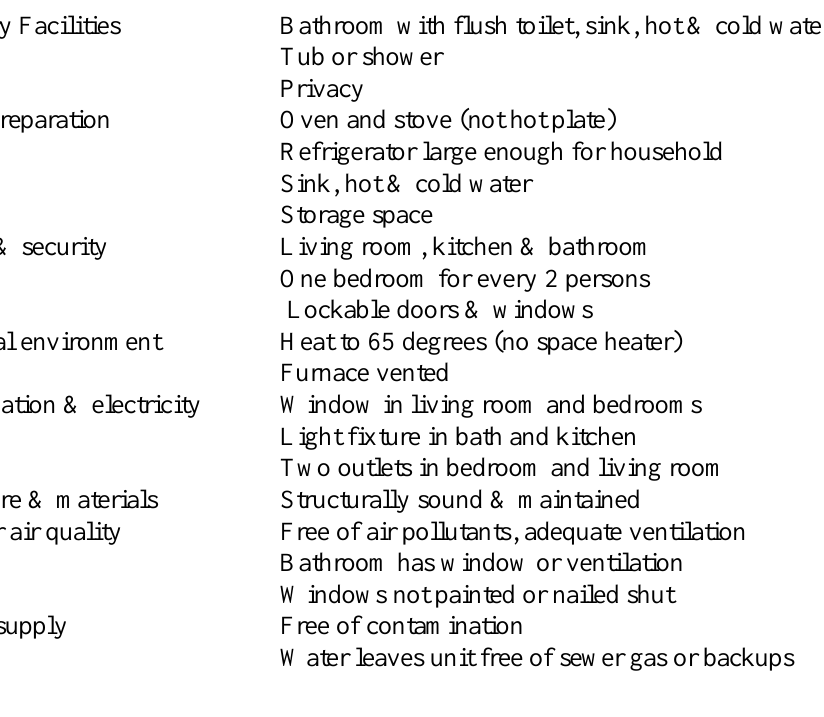
Housing Standards for Housing Choice Vouchers in the